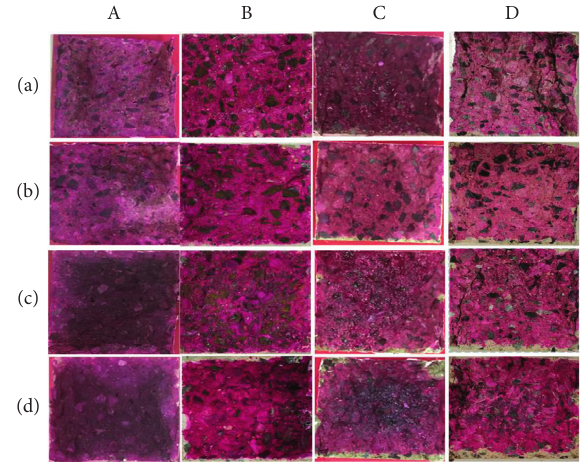
Figure 4: Images of concrete specimens sprayed with phenol- phthalein indicator (1 :100% OPC (G0), 2: 70% OPC (G30), 3 :50% OPC (G50), and 4: 30% OPC (G70)). Note. A B, C, and D represent 7, 150, and 180 days and 1-year exposure result for concrete groups in natural carbonation